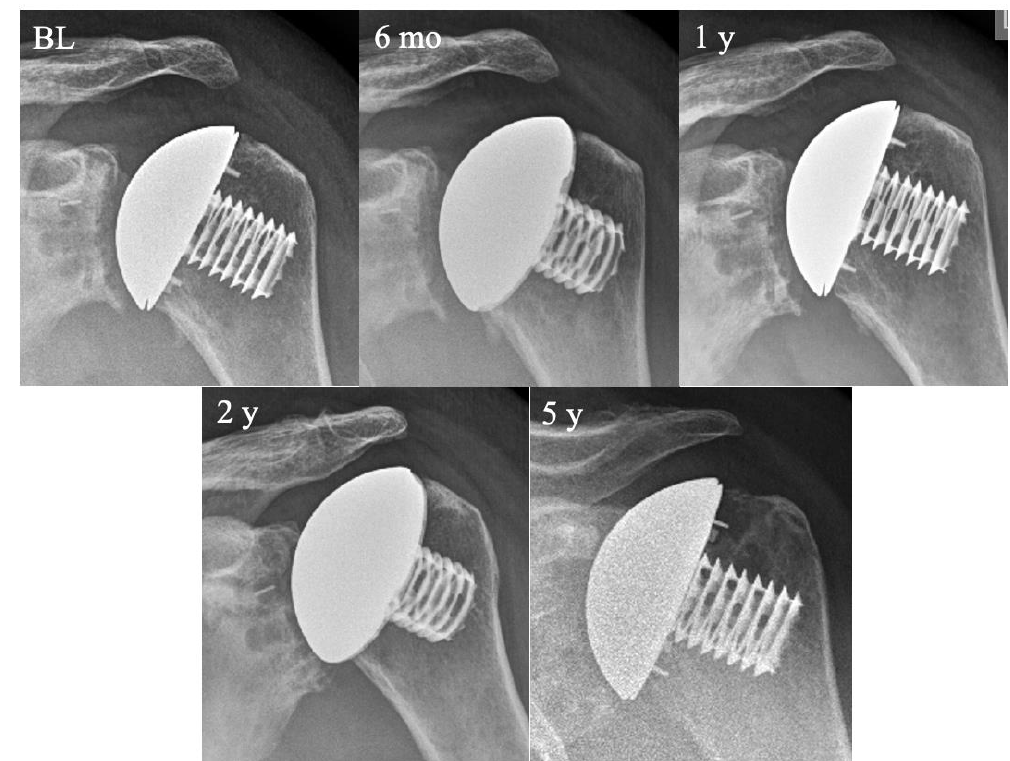
Figure 4. Progression of medialization and cranialization over time. Anteroposterior radiographs with the patient positioned in internal rotation. Images depict time points immediately after surgery (baseline, BL) and follow-ups after six months (6 mo) and one, two, and five years later (from top left to bottom right).